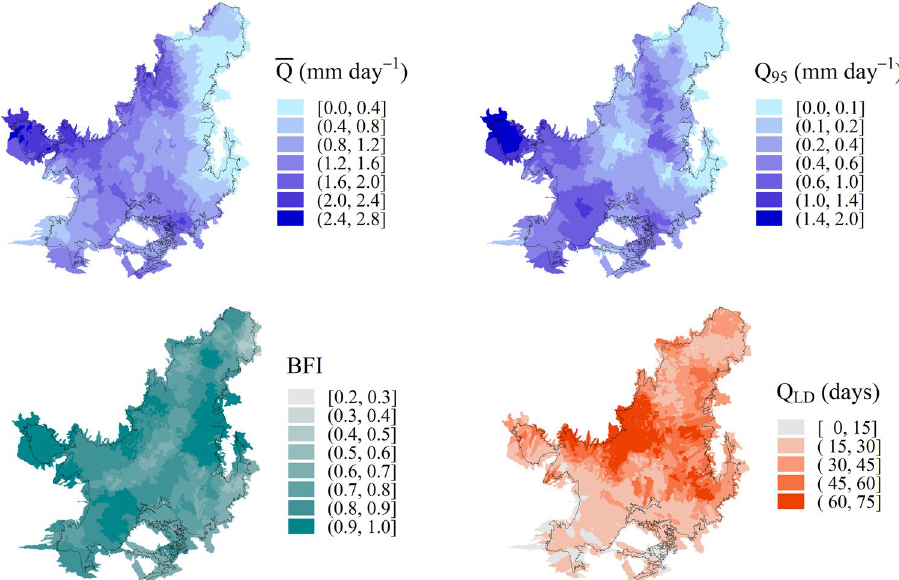
Fig. 5 Time series of the streamflow and various hydrological signatures for an arbitrary ottobasin (ID = 74,929). centile of the daily flow, BFI = baseflow index, and Q LD = low-flow event (Q < Q 80 ) duration